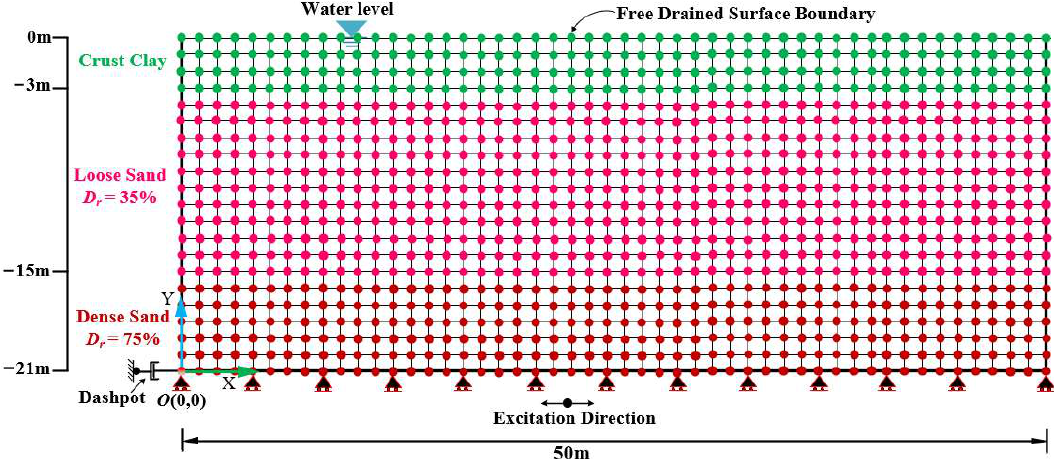
Figure 1. Configuration of numerical model of generic liquefiable site.